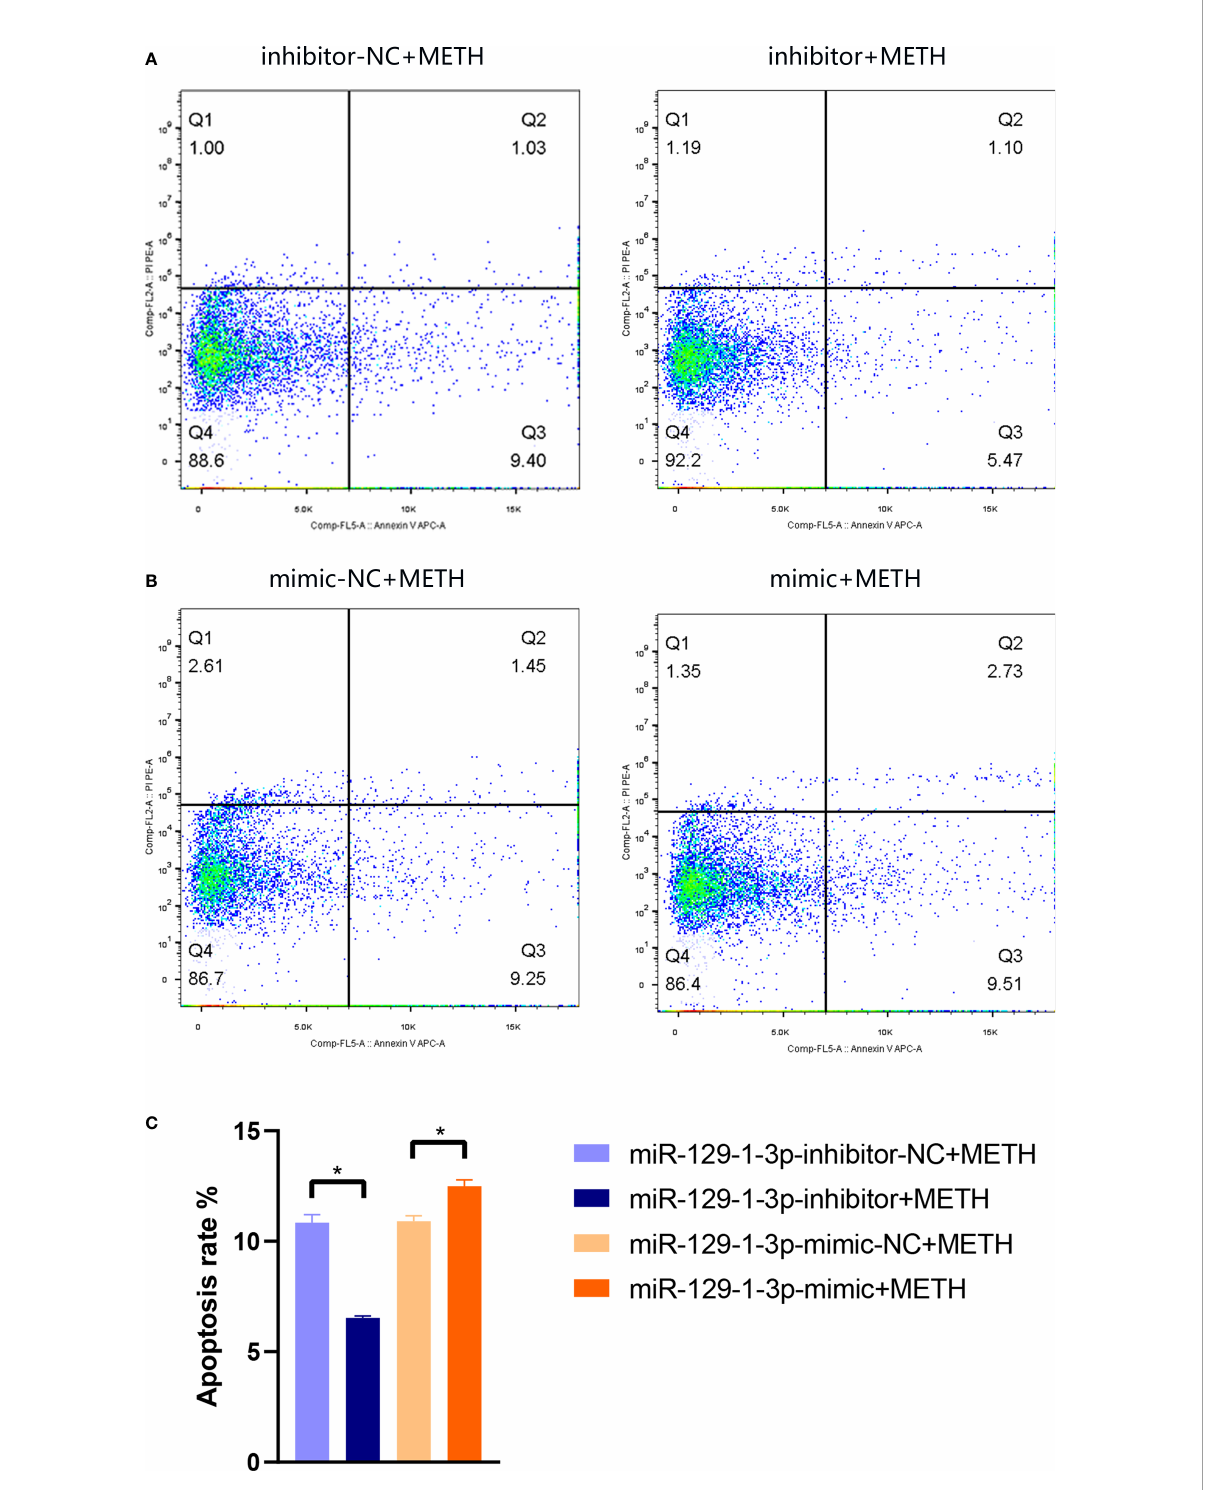
FIGURE 2 Flow cytometry analysis of apoptotic SH-SY5Y cells in (A) miR-129-1-3p inhibitor-NC + METH group and miR-129-1-3p inhibitor + METH group and (B) miR-129-1-3p mimic-NC group + METH and miR-129-1-3p mimic group + METH. (C) The apoptosis rate = percentage of early apoptosis (Q3) + percentage of late apoptosis (Q2). Signi fi cant differences are indicated by asterisks. Error bars represent the mean ± SEM. *P<0.05. mimic- NC: miR-129-1-3p mimic-NC, inhibitor-NC: miR-129-1-3p